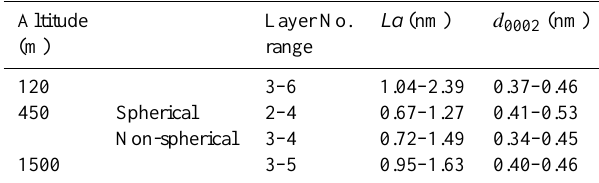
Fig. 1. TEM images of aerosols from (a) 120, (b) 450 and (c) 1500 m altitudes. Small spherule soot and brown carbon spheres are marked by black and white arrows, respectively. Table 1. Parameters for the BSU of soot spherules in three altitudes, Layer No. range, La and d 0002 are range in number of graphene layers, length and the d spacing of the stacking layers inside BSU, respectively. Altitude Layer